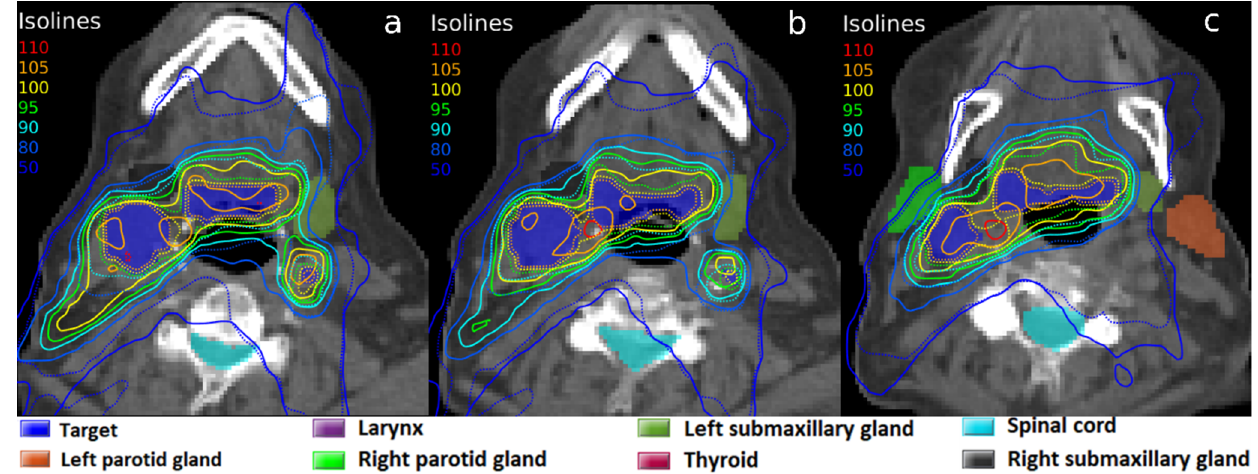
Figure 5. Isodoses in three axial CT slices ( a – c ) corresponding to the radiotherapy treatment planning with the MV-CBCT beam, optimized for each configuration: without AuNP (solid line), and with a simulated 22.3 mg Au·g − 1 tissue concentration of AuNP in the target volume (dotted line). 100% isodoses represent the prescribed dose of 70 Gy.